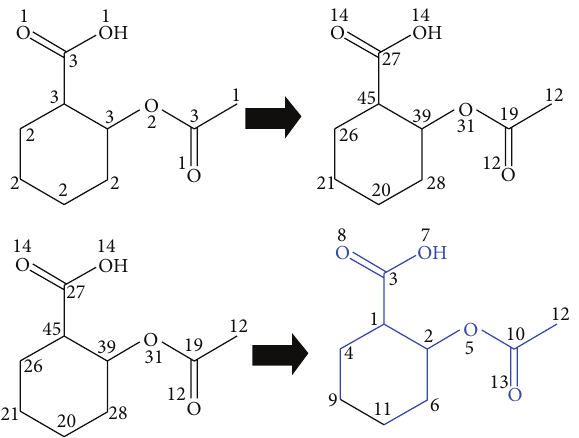
Figure 2: Construct atomic connectivity values in GBMD using Morgan algorithm.